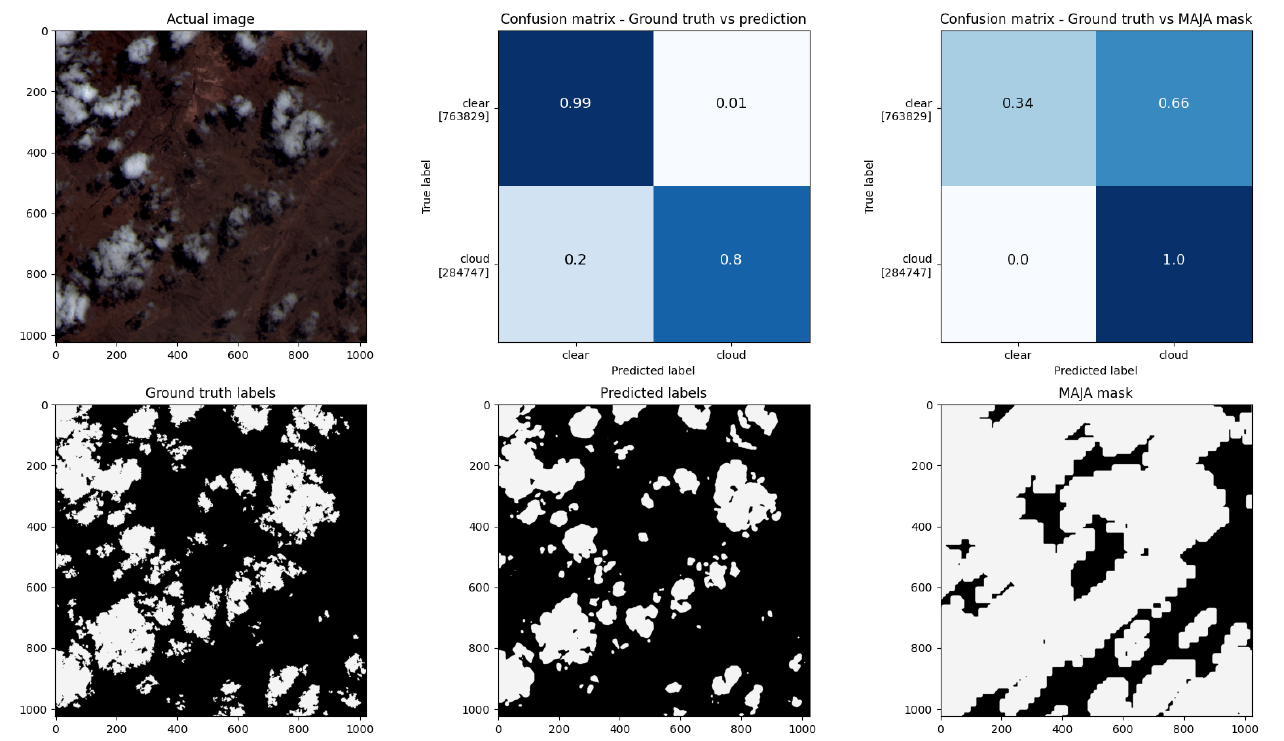
Figure 16. Comparison of the MAJA cloud mask and results from the binary detection of U-Net without dropout layers trained on the full-band dataset. A patch of S05 tile covering an arid